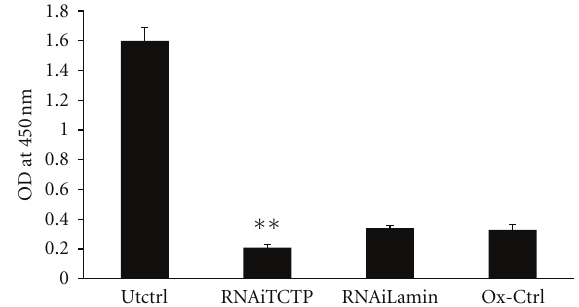
Figure 3: Knock down of TCTP by siRNA sensitizes cells to oxidative stress. Knocking down the wild-type TCTP with siRNA (RNAiTCTP) before exposing the cells to H 2 O 2 significantly reduced the viability of human granuloma cells. Cells transfected with lamin SiRNA (RNAiLamin) or nontransfected cells exposed to the same conditions (O x -Ctrl) or cells without exposure to H 2 O 2 (Utctrl) served as controls. Data presented is average of 3 wells and is representative of three similar experiments. ∗∗ P < 0 . 05 compared to control siRNA (RNAiLamin) transfected